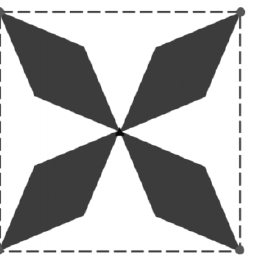
Figure 10. Diagram of the effective utilization factor.